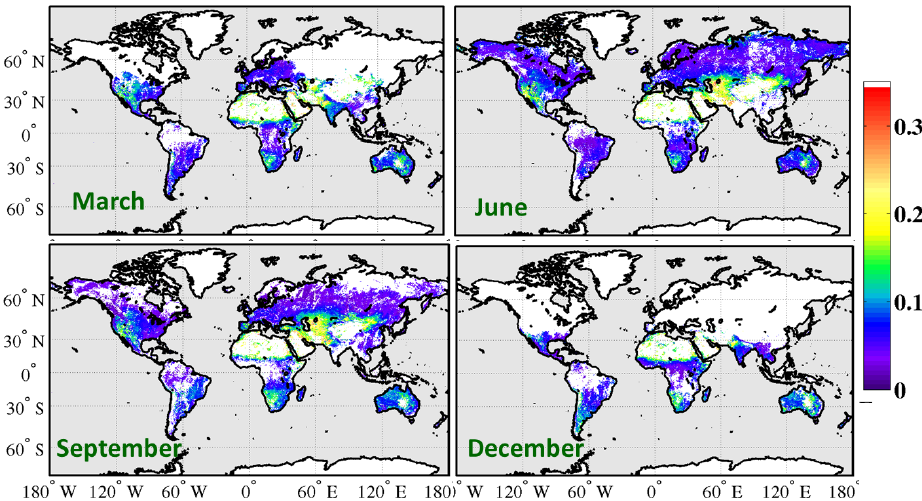
Figure 3. Monthly aggregated surface reflectance at 555nm retrieved from AATSR with ADV for March, June, September and December 2007.